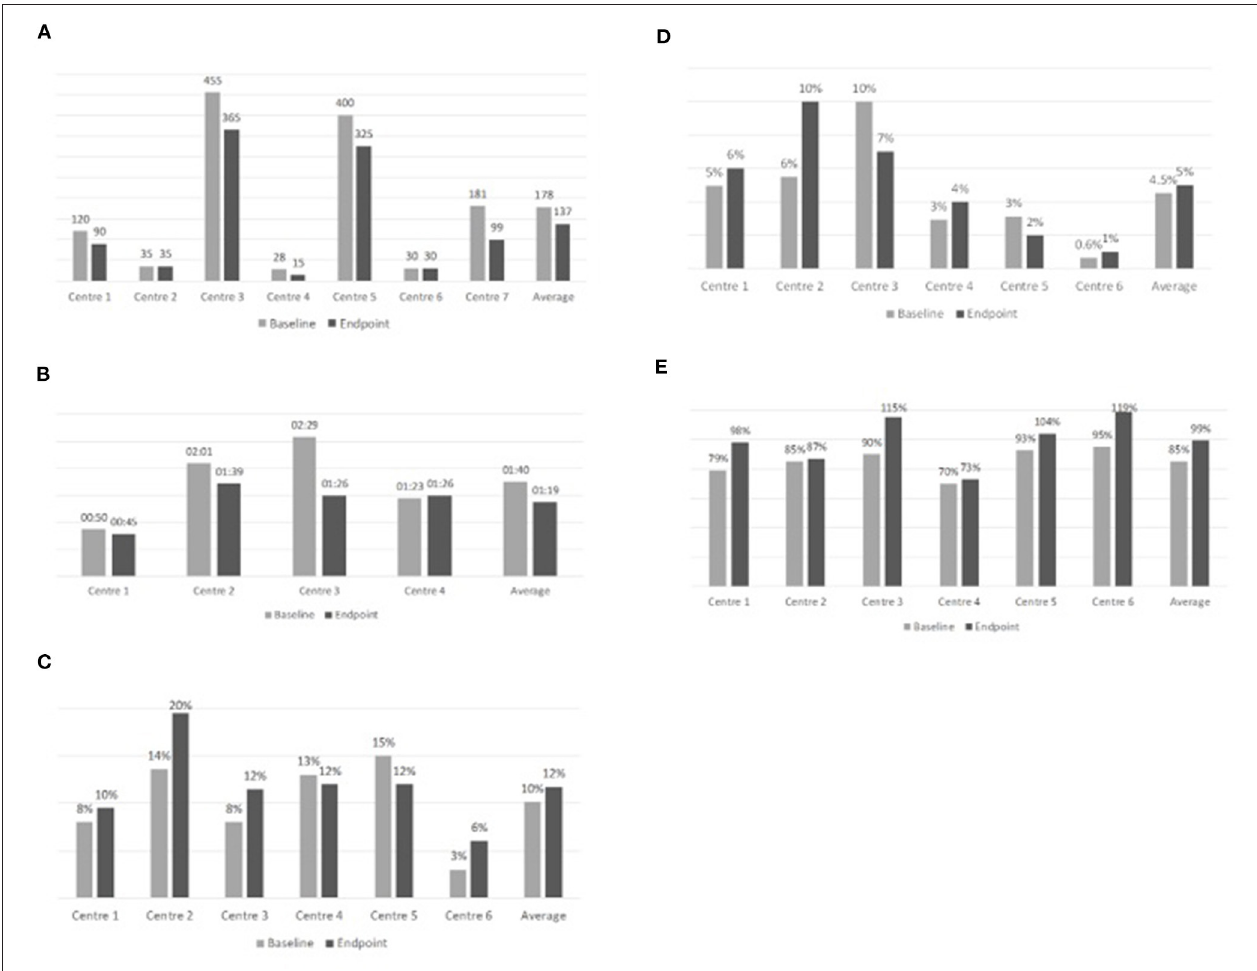
FIGURE 4 | Overview of results achieved during the “Early SpA Clinic” project after implementation of organizational solutions. (A) Waiting lists (days). (B) Time required by a patient to transit the Center (hours). (C) Percentage of new diagnoses of Rheumatology patients (%). (D) Percentage of new SpA diagnoses (%). (E) Saturation of production capacity